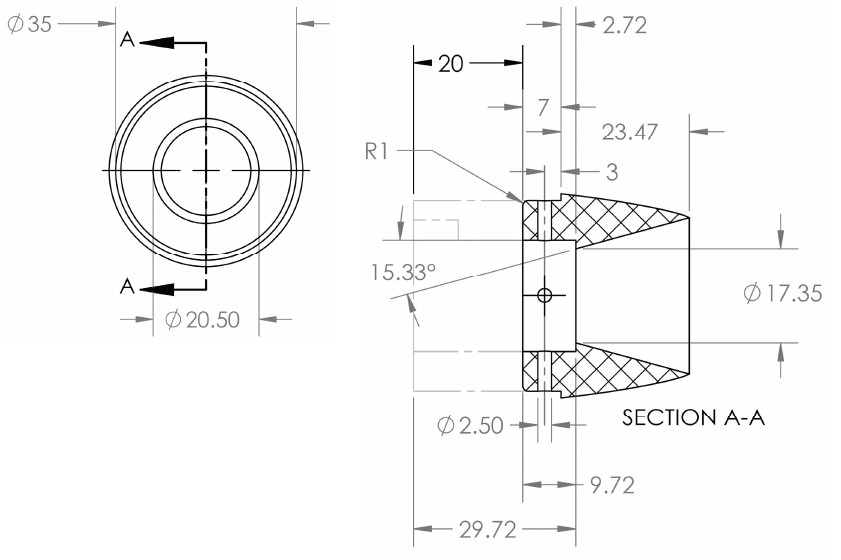
Figure 2. Milly—Graphite insert to improve motor